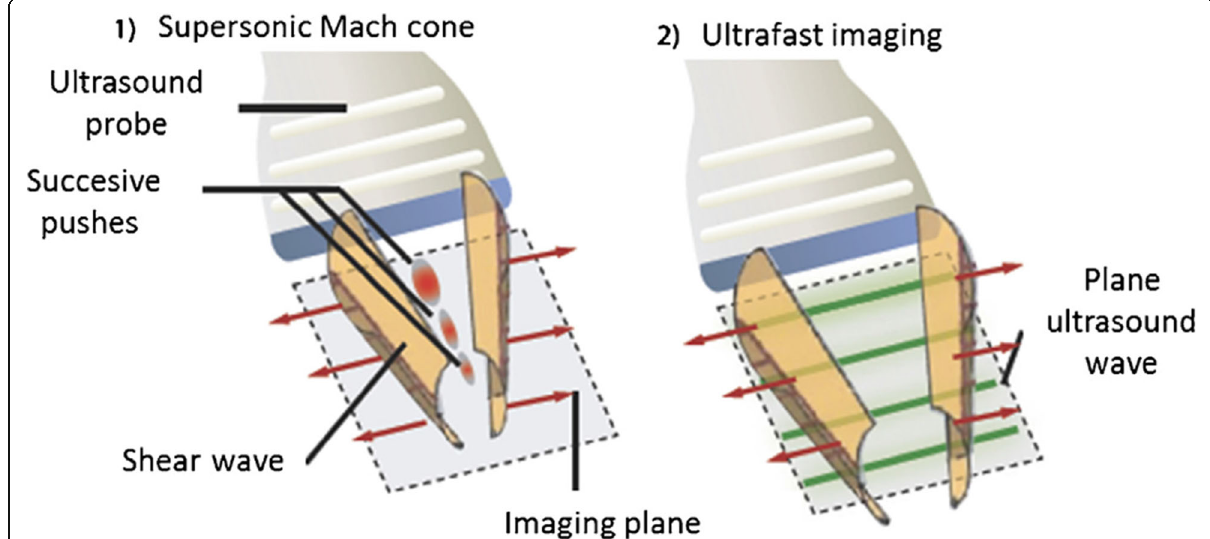
Fig. 11 The ultrasounds are successively focused at different depths to create pushes by radiation pressure. (1) The constructive interferences of the shear waves form a supersonic Mach cone (in which the speed of the source is greater than the speed of the generated wave) and a quasi- plane shear wave is created; (2) the ultrasound machine then switch into an ultrafast imaging mode to follow the shear wave that is propagating through the medium